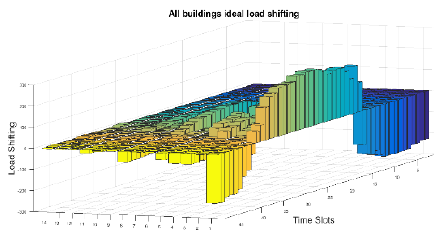
Figure 9. At a glance load shift suggestions per building per time slot